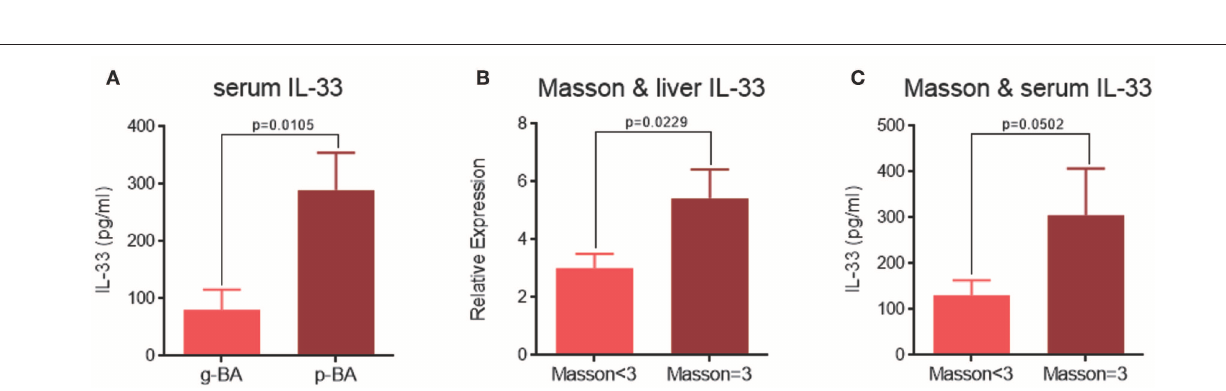
FIGURE 3 | The relation of IL-33 expression levels with BA prognosis and liver fibrosis. (A) Serum IL-33 expression levels between g-BA and p-BA groups. (B) Liver IL-33 expression levels by IHC in patients with different Masson scores. (C) Serum IL-33 expression levels by ELISA in patients with different Masson